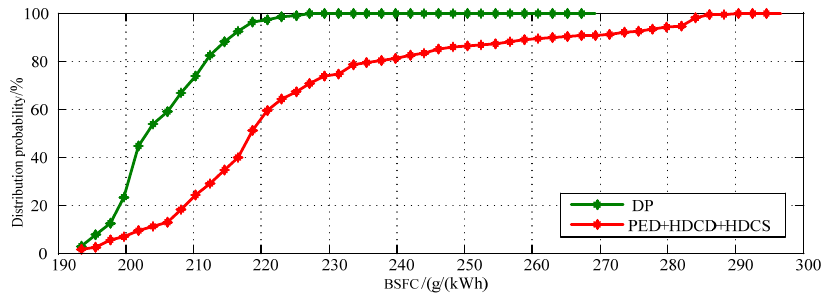
Figure 21. The statistical results of the BSFC of the working points of the ICE under the two types of strategies.